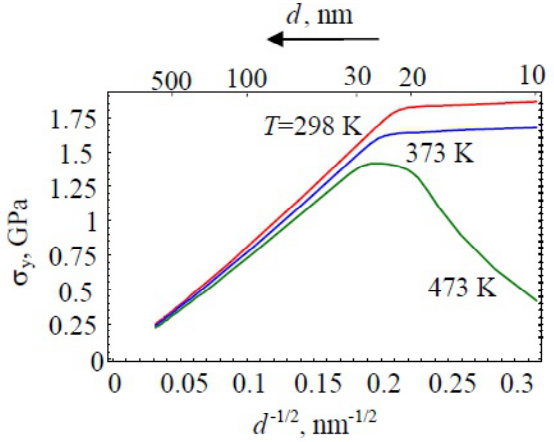
Fig. 6. The dependences of the yield strength  polycrystalline Ni on the inverse square root, d -1/2 , of grain size d , for various values of absolute tem- perature T .